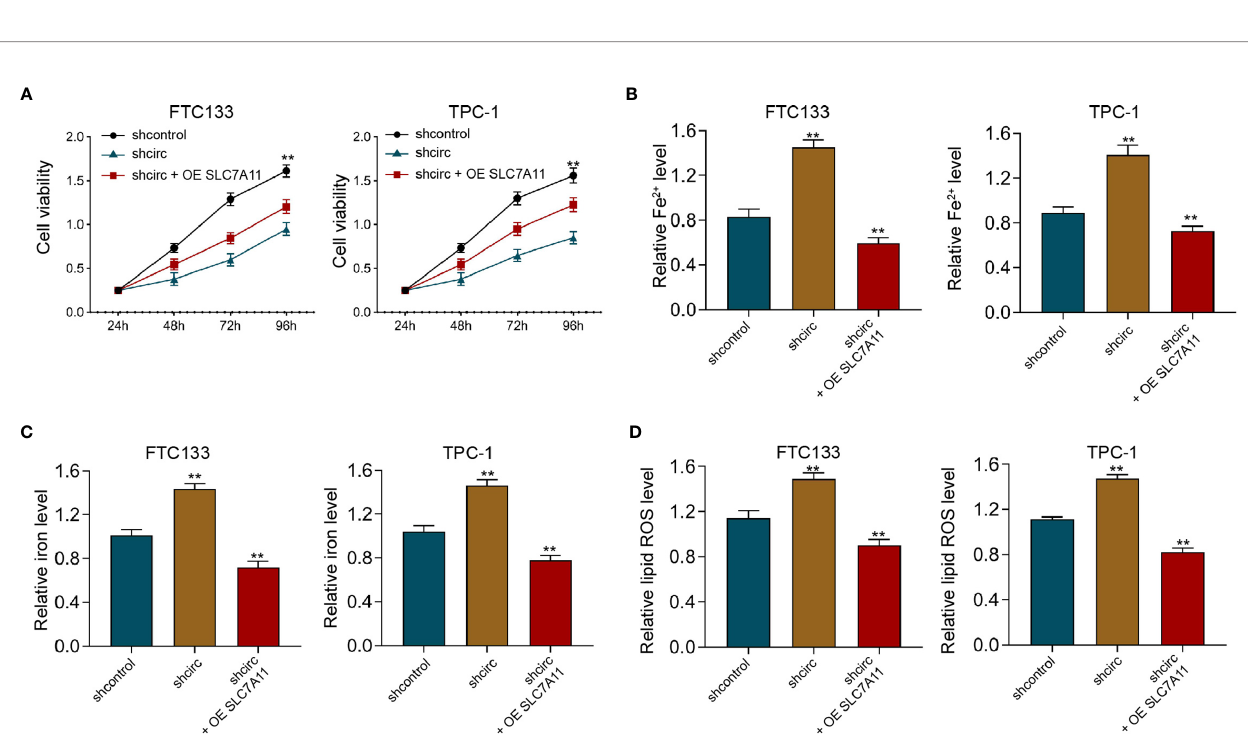
FIGURE 7 | SLC7A11 overexpression reverses Circ_0067934 knockdown-enhanced ferroptosis of thyroid cancer cells. (A) The analysis of FTC133 and TPC-1 cell viability by MTT assays. (B – D) Analysis of Fe 2+ , iron, and ROS levels in FTC133 and TPC-1 cells. mean ± SD, ** P <